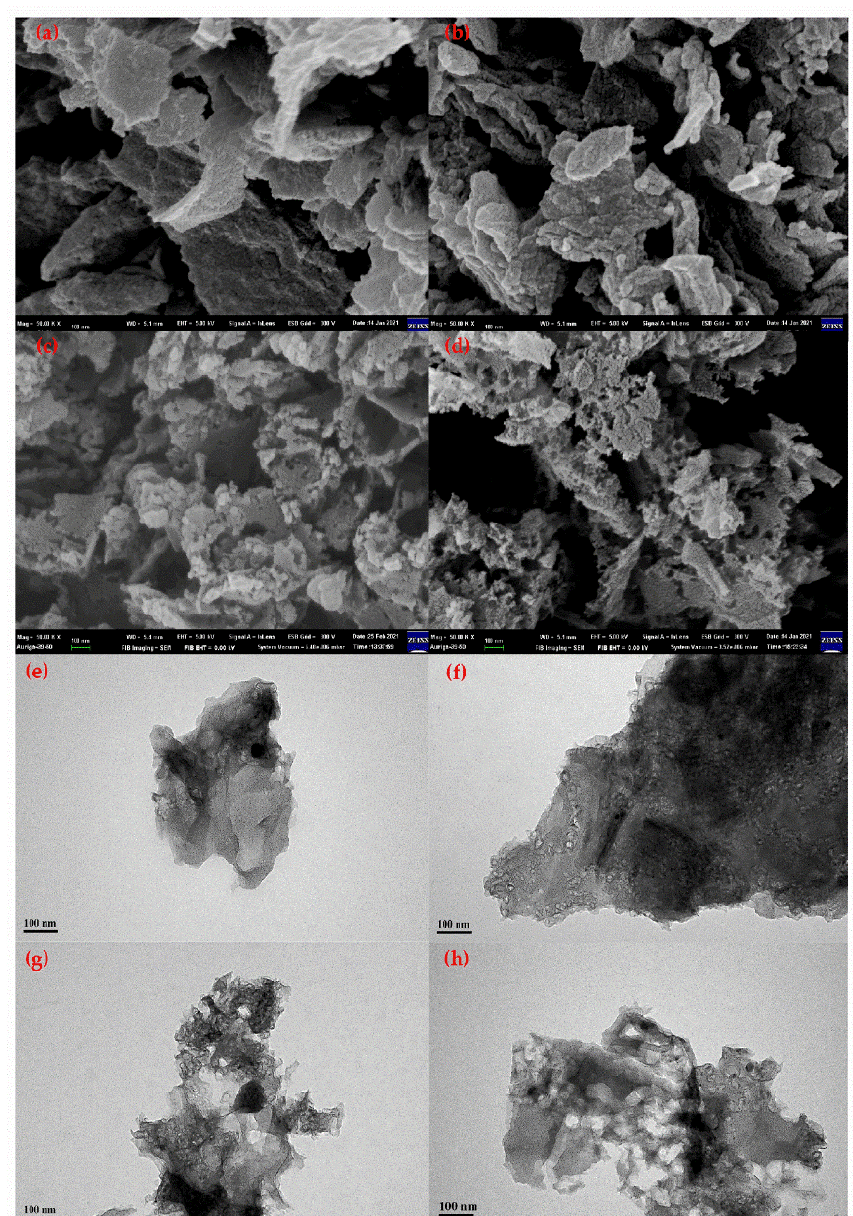
Figure 6. SEM and TEM micrographs of ( a , e ) CoNC-1000; ( b , f ) CoNC-1000A.;( c , g ) CoNC-1000A-900; and ( d , h ) CoNC-1000A-900A.